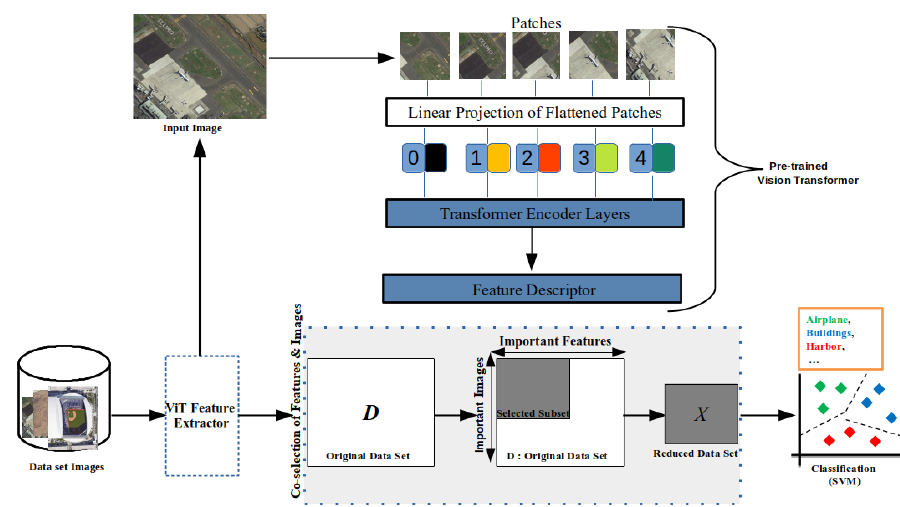
Figure 1. Overall architecture of the proposed method.